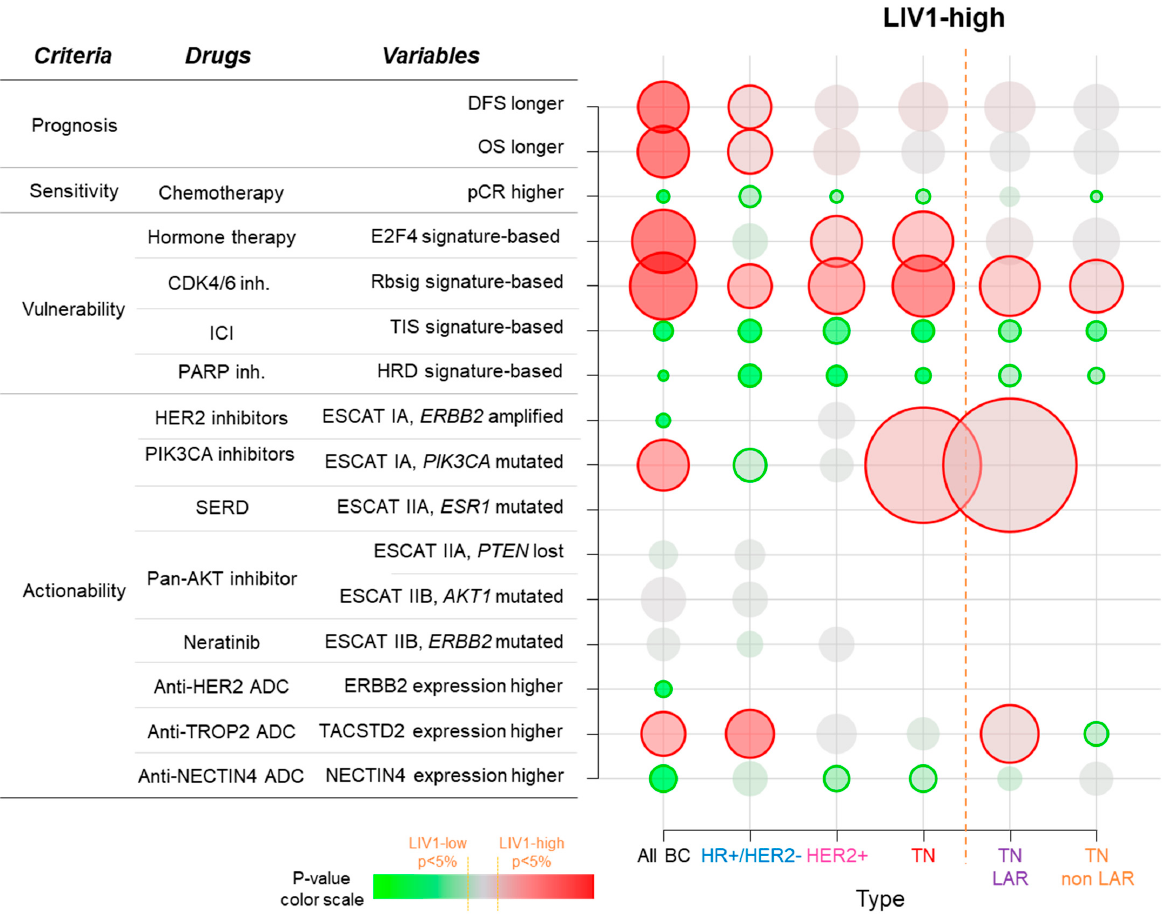
Table 3. Univariate and multivariate analyses for OS in the whole